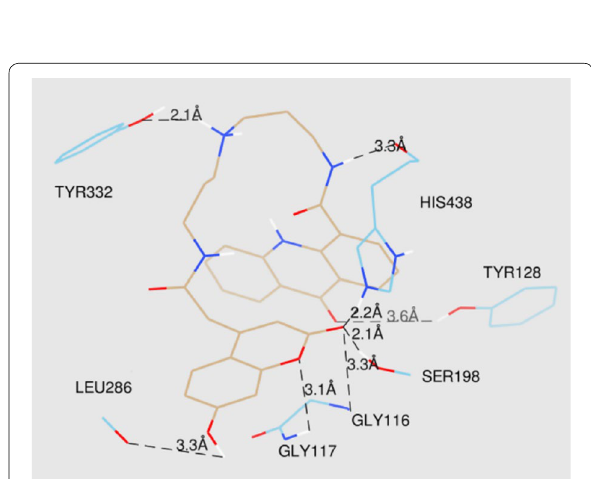
Fig. 49 Top-score docking pose of derivative C45f depicting its putative hydrogen bonds formed with amino acid residues in the active-site gorge of hBuChE [54]